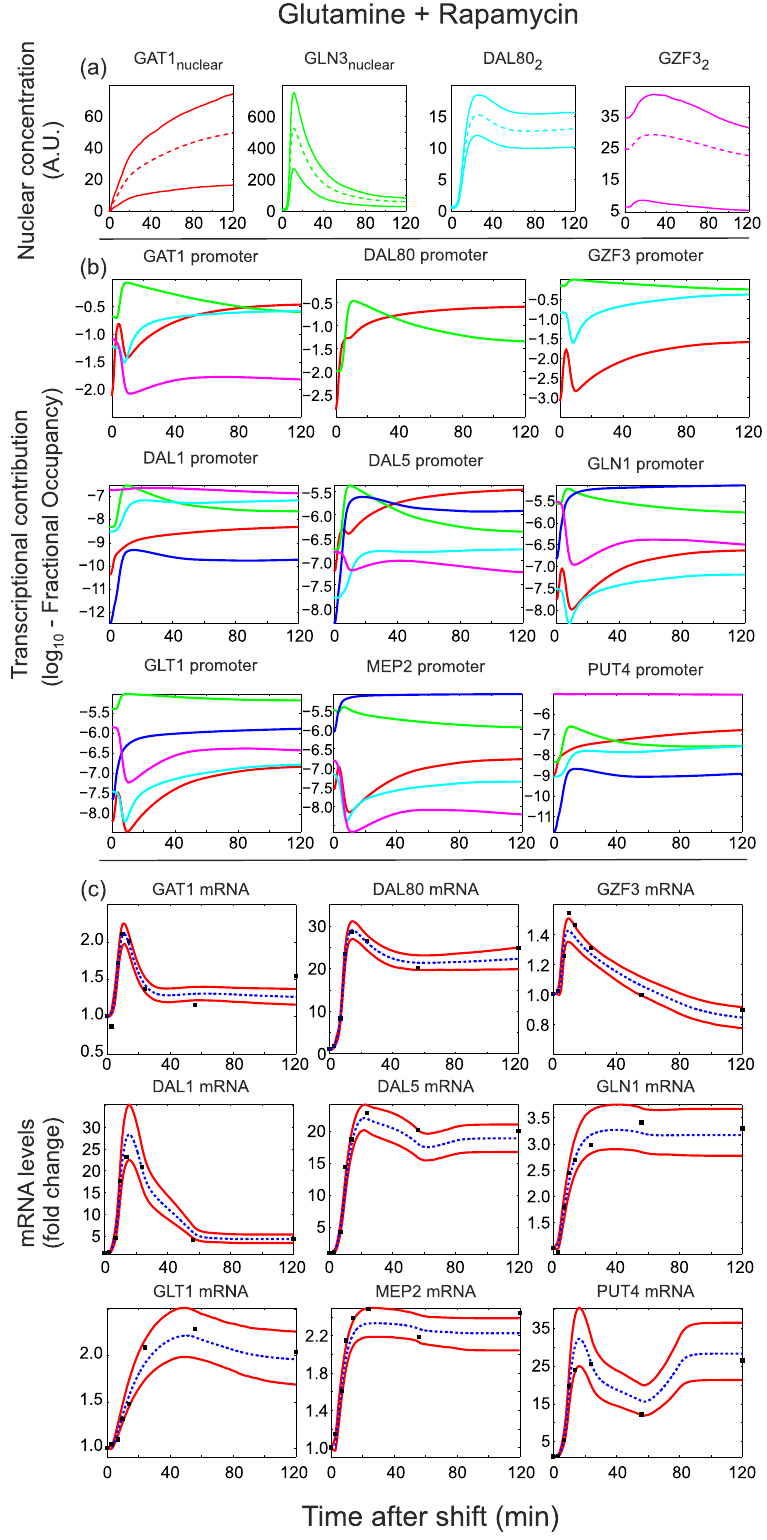
Fig 7. Model M 135 predictions and fi ts to target mRNA data (fold changes) for the Gln+Rap shift. Panel description is identical to Fig 6.